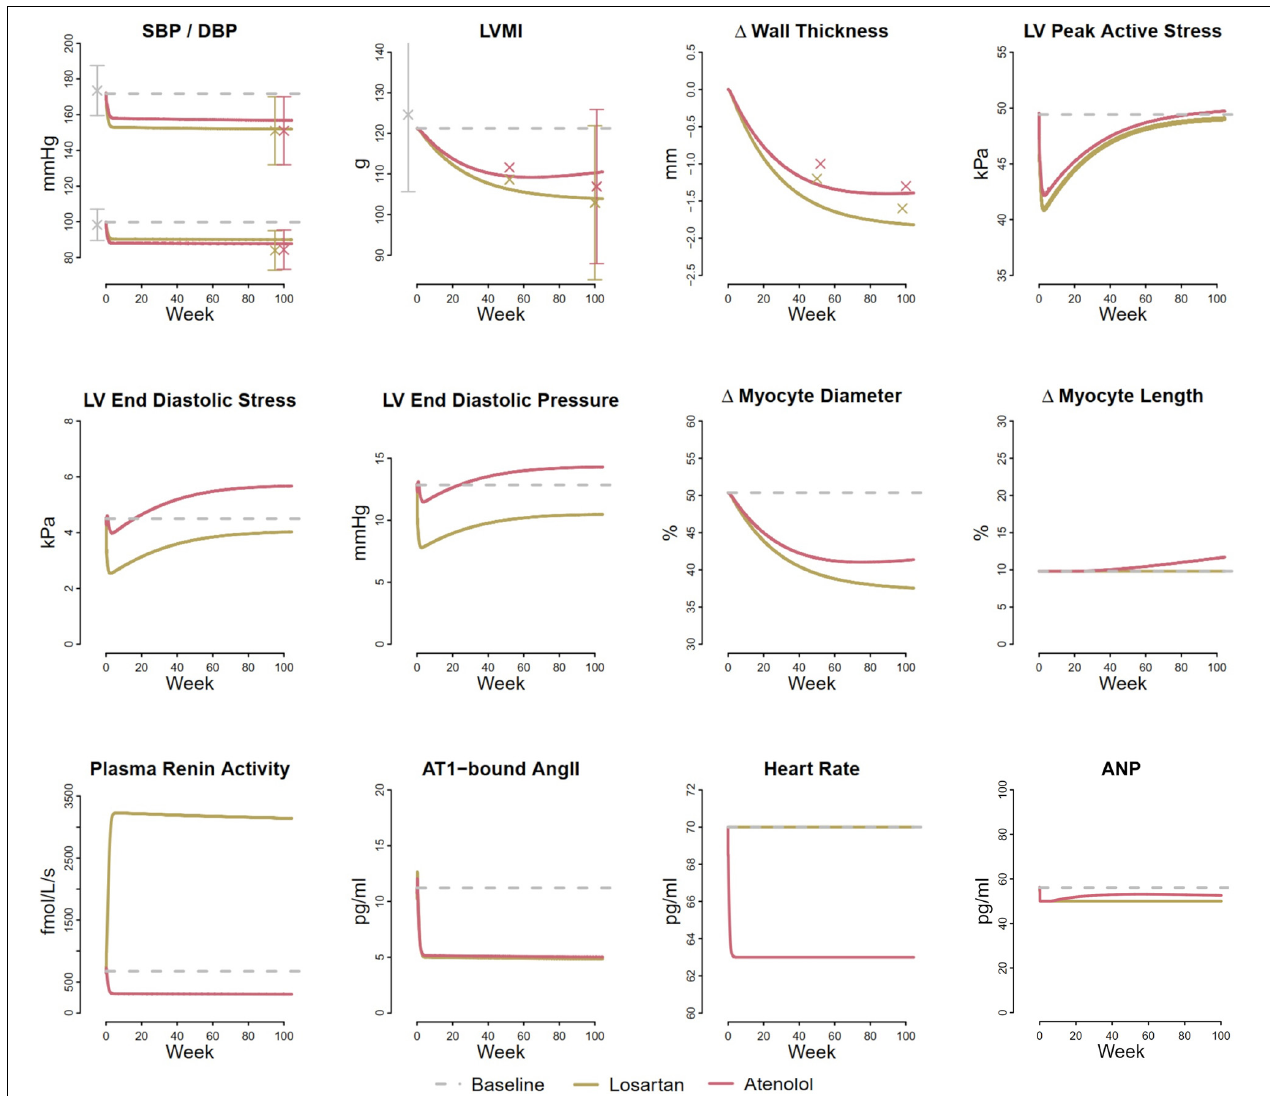
FIGURE 6 | Model reproduces larger reduction in LVMI and wall thickness with losartan compared to atenolol observed in the LIFE clinical trial (Devereux et al., 2004). Both treatments reduce LV peak active stress, but losartan reduces LV end diastolic stress, while atenolol increases